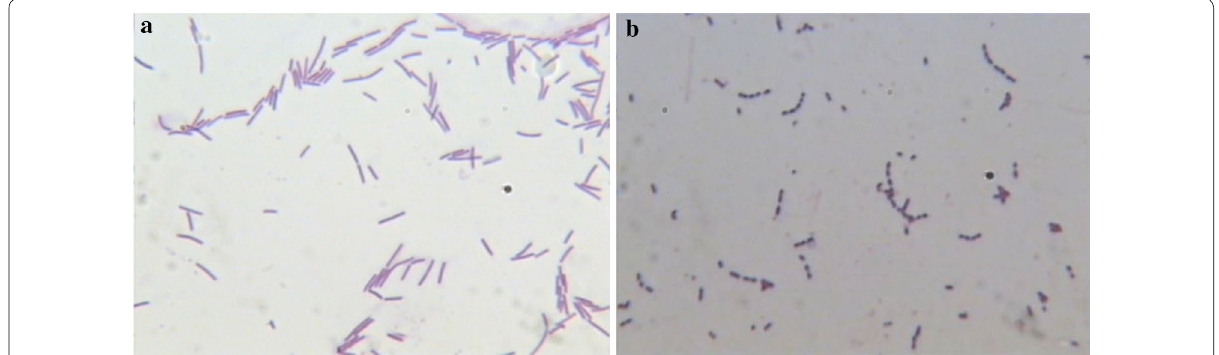
Fig. 1 Gram staining and microscopy of colonies. a Represents TMP and b represents TSP